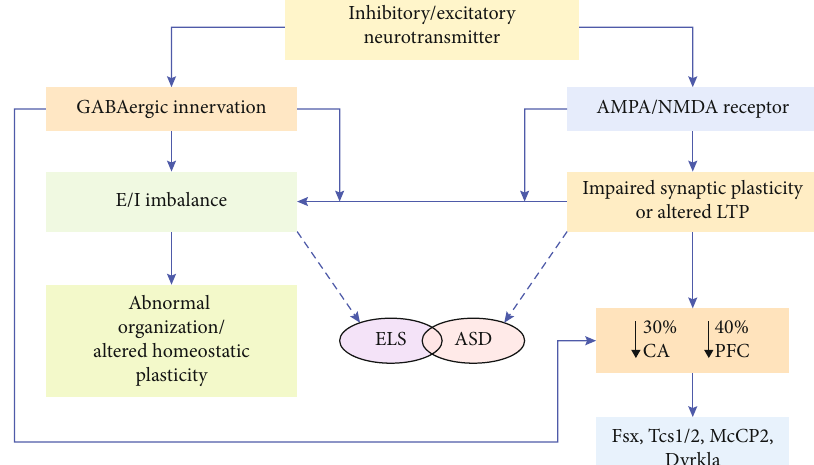
Figure 1: Genetic pathologies linked with epilepsy and ASD. Synaptic plasticity can be altered by epilepsy or seizures in an early phase of infantile development leading to ASD. Anomalies in neural plasticity can be a result of malfunctioning neurotrophins, signaling molecules, or receptors, resulting in a 30% reduction in dendritic spine density in hippocampus (Cornu Ammonis) CA3 neurons and a 40% reduction in prefrontal cortex (PFC) neurons. Several genes involved in autism and epilepsy pathogenesis have been linked to this biochemical pathway critical in brain development and